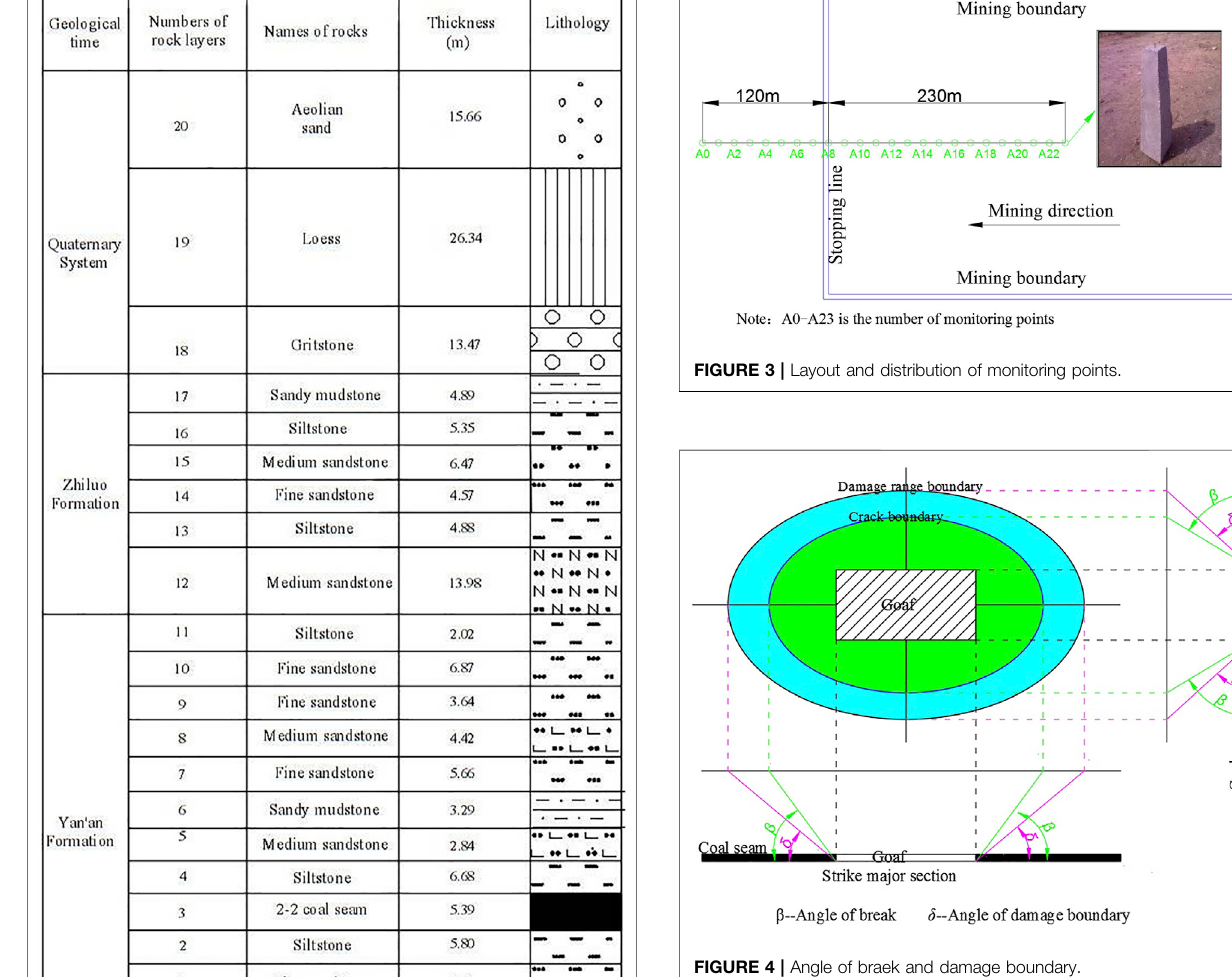
FIGURE 4 | Angle of braek and damage